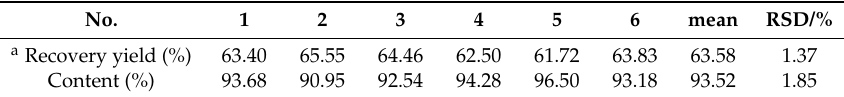
Table 3. Verified results of preparation and purification tests by D4020 macroporous resin.